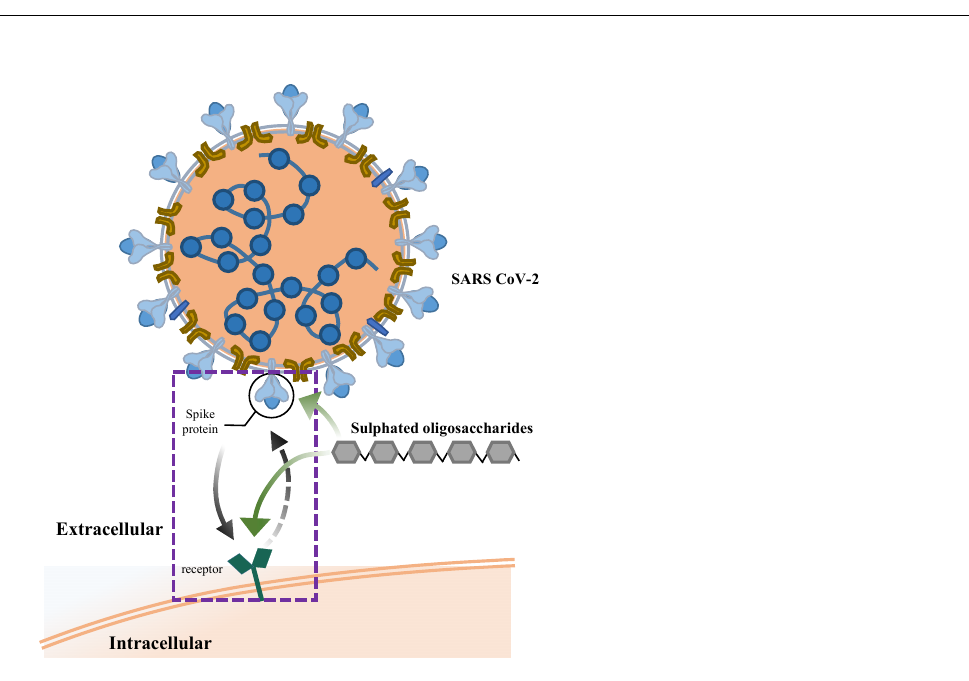
Figure 5. Schematic representation of the FOSs binding to the COVID-19 spike protein. FOSs (green arrow) suppress the viral attachment to receptor and subsequently its entry inside the host cell (black arrow).